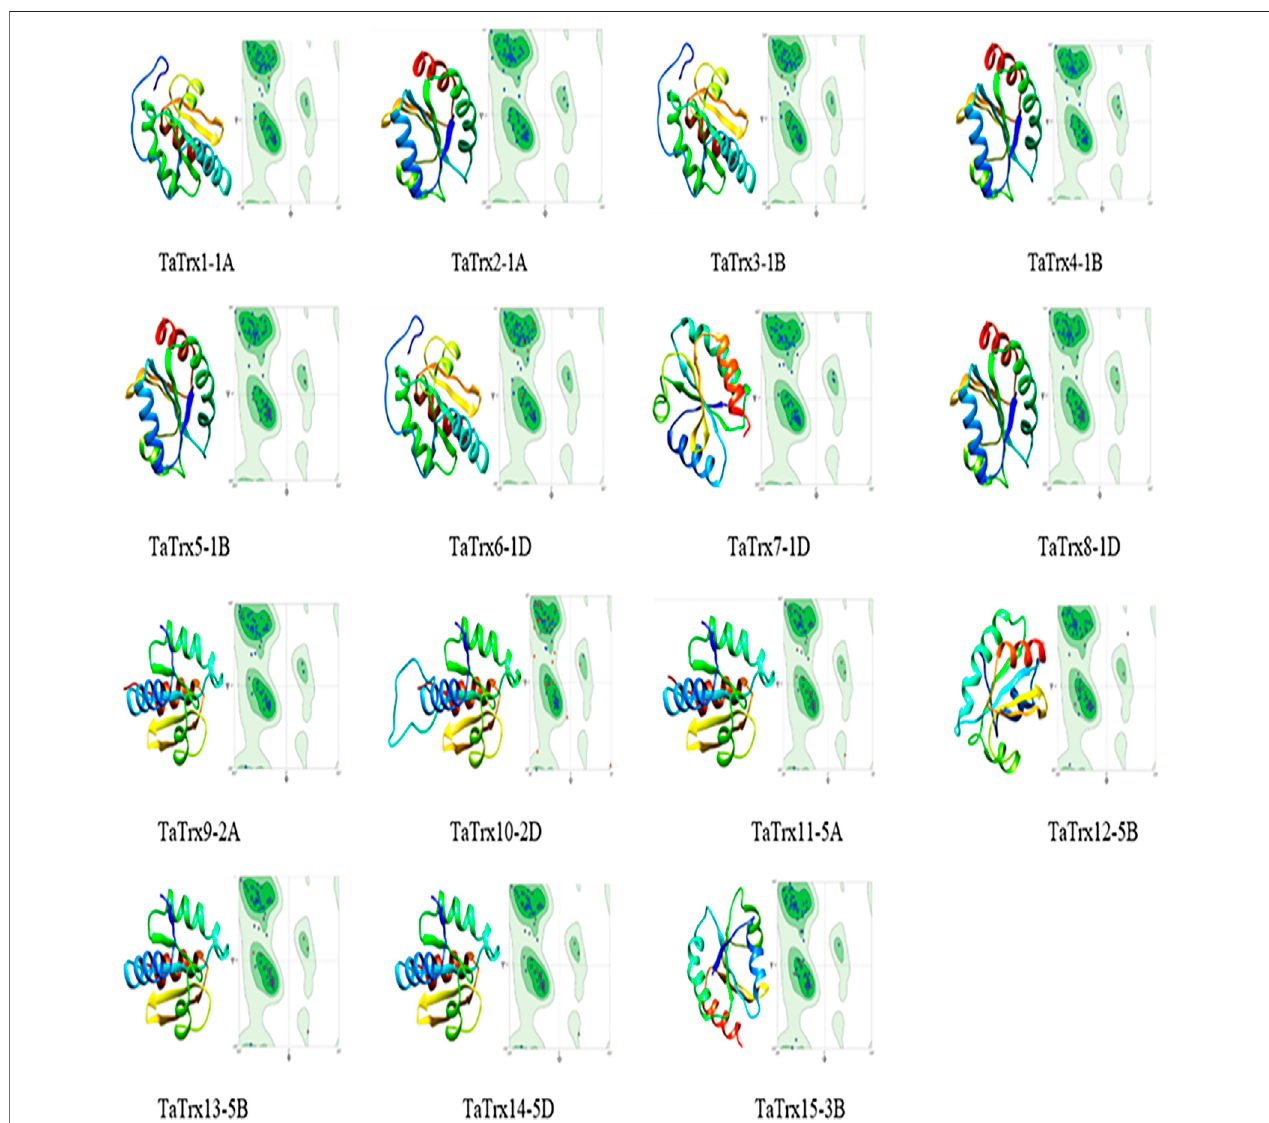
FIGURE 5 | Automatic prediction of 3D structure and homology modeling of TaTrx proteins generated using UCSF chimera (http://www.cgl.ucsf.edu/chimera). Ramachandran plot of corresponding TaTrx protein showing most favored region and allowed region created using SWISS-MODEL server.